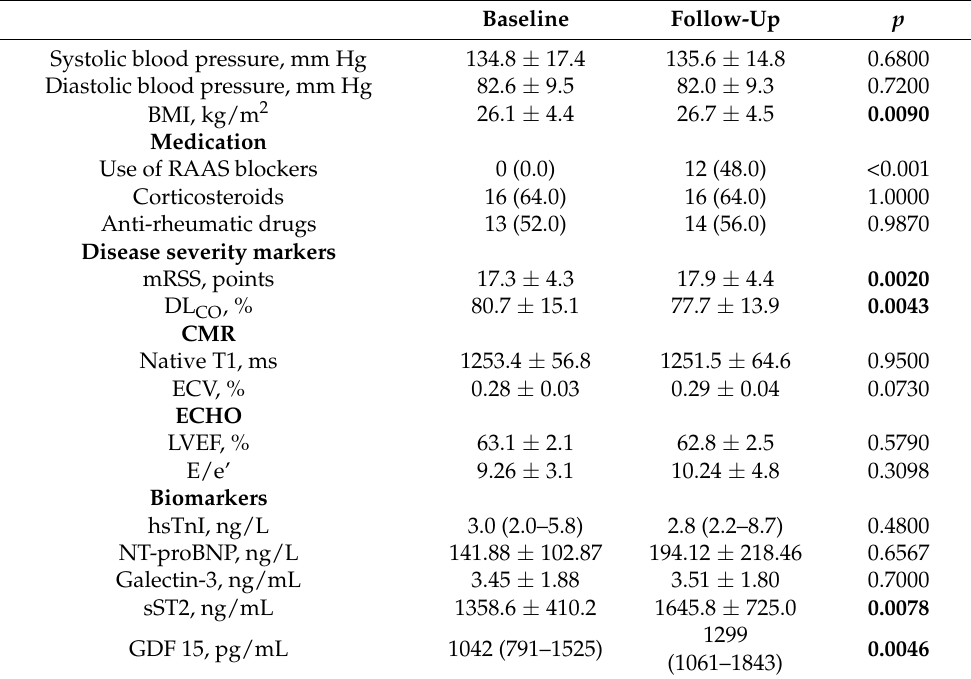
Table 1. Changes of selected parameters over five years of follow-up.